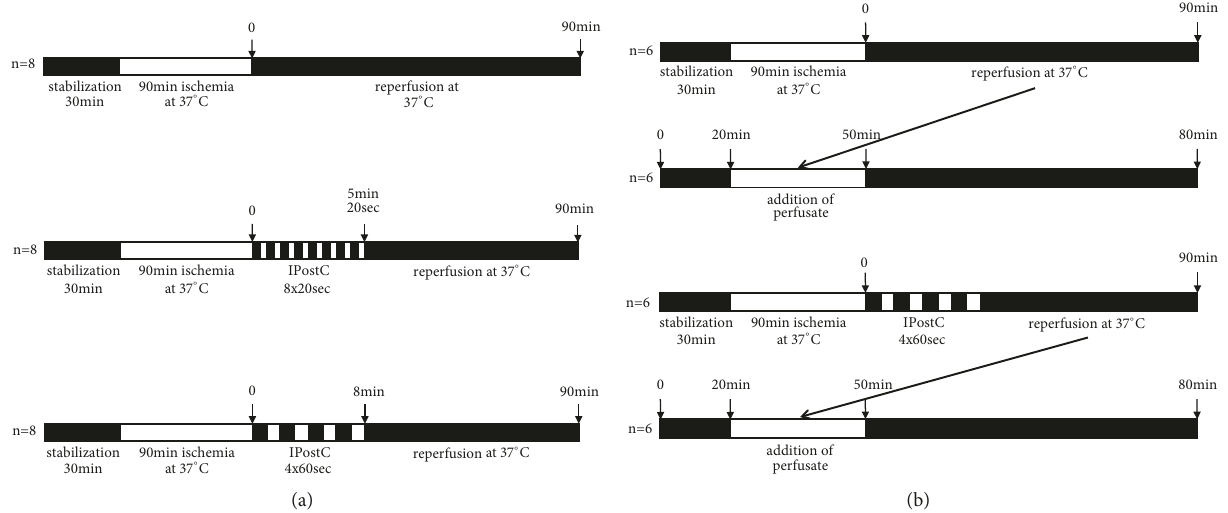
Figure 1: Experimental protocols for animal studies . (a) Male SD rats underwent bile duct ligation over 4 weeks to induce liver fibrosis or received thioacetamide via drinking water over 18 weeks to induce liver cirrhosis. For the implementation of warm ischemia, healthy, fibrotic, and cirrhotic livers were perfused for 30 min, stored for 90 min at 37 ∘ C, and reperfused for 90 min. The IPostC intervention groups included 8x20 sec and 4x60 sec cycles that were performed after ischemia (control and intervention groups, each n=8). (b) For the follow-up study, we performed warm ischemia in healthy livers of male SD rats (postconditioned with IPostC 4x60 sec and nonpostconditioned, each n=6) and collected the reperfusion perfusate to perfuse a second healthy liver for 80 min. Table 1: Histological evaluation of healthy, fibrotic, and cirrhotic livers after warm ischemia ± IPostC. Liver